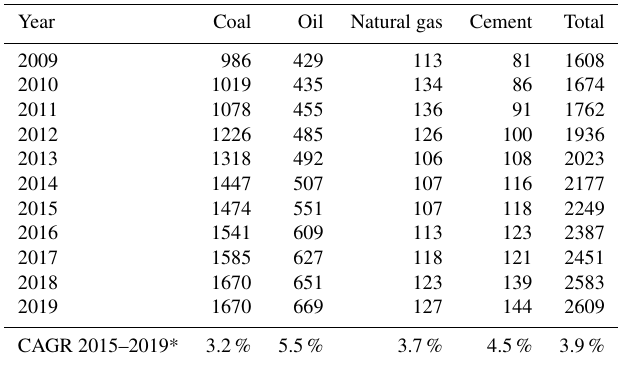
Table 1. Calendar-year CO 2 emissions in India by category, in mil- lions of